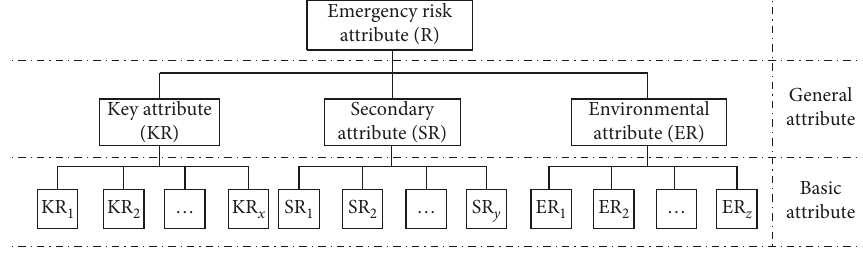
Figure 1: Emergency risk attribute identification framework.